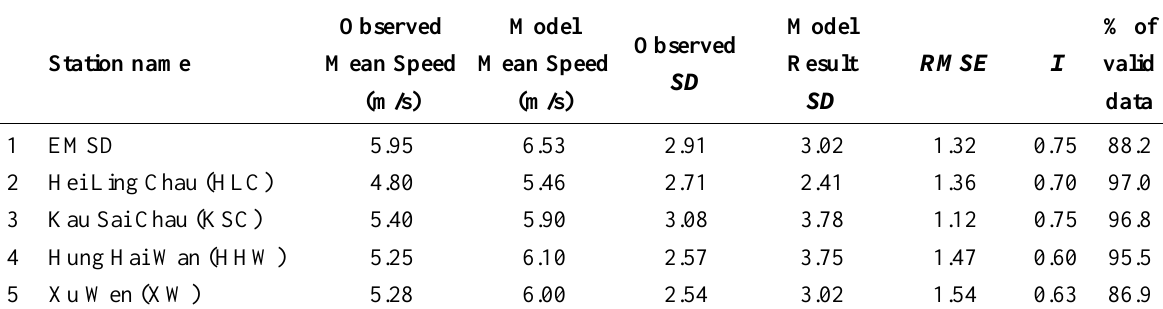
Table 3. The statistical results of five field data